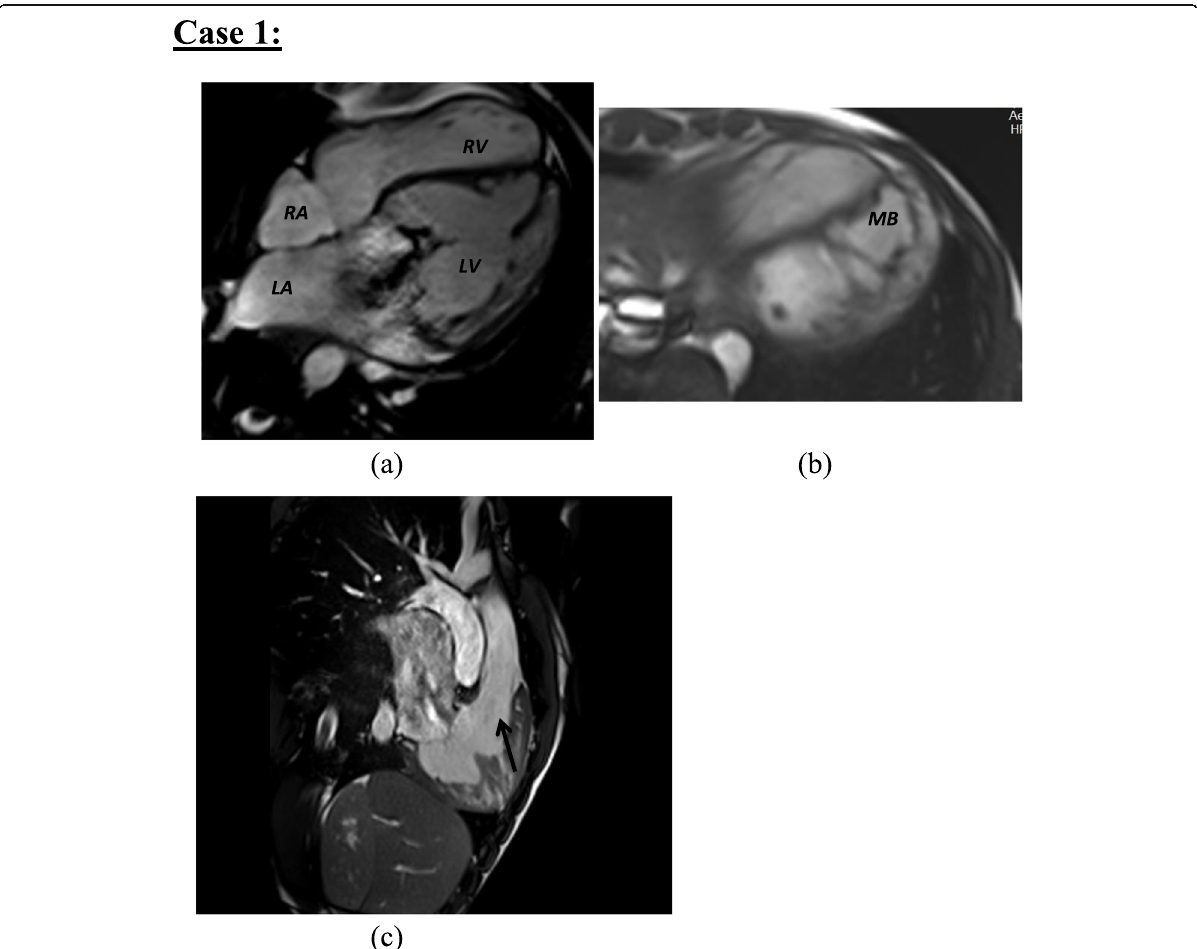
Fig. 1 a , b Cine MRI image of 4-chamber cardiac view for a case of L-TGA showing the RA connected to a right-sided, smooth-walled, morphologic LV and the left atrium connected to a trabeculated, left-sided, morphologic RV. The mitral valve displaced more basally than the tricuspid valve. a The image shows the moderator band (MB) of the left sided morphologically right ventricle ( b ). c Right ventricular outflow tract showing the regurgitant jet at the tricuspid valve region